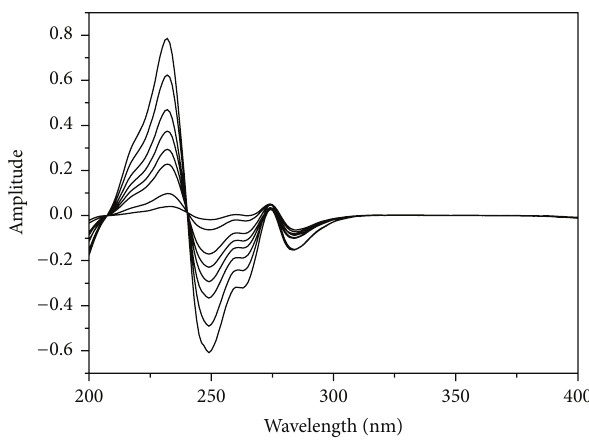
Figure 7: First derivative of smoothed ratio of AA (4–50 𝜇 g/mL) using 8 𝜇 g/mL of RU as a divisor and methanol as